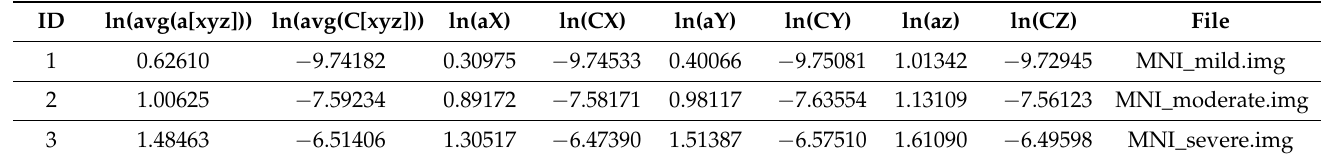
Table 1. Contents of variogram parameter file